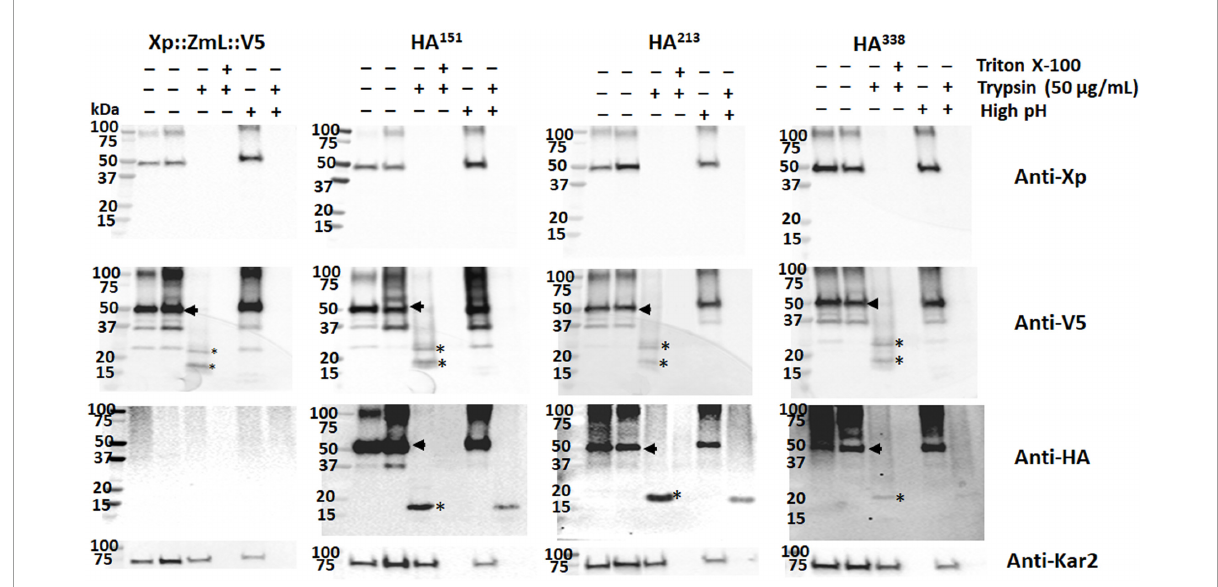
FIGURE5 Sequential high pH membrane reformation/protease protection assay of microsomes containing DGAT1. High pH conditions reformed the sealed microsomal compartment, allowing protease cleavage of luminal domains from integral domains embedded in the membrane bilayers (Wu et al., 2003). The addition of trypsin alone resulted in the total disappearance of the Xpress (Xp) tag and the appearance of conserved fragments containing the V5 tag; when both trypsin and triton X-100 were added the V5 signal was also lost. Combining high pH treatment with trypsin digestion resulted in the disappearance of the V5 tag of all Xp::ZmL::V5, Xp::ZmL-HA 151 ::V5 (HA 151 ), HA 213 , and HA 338 . The data indicates the C-terminus is located in the lumen. In contrast to the C-terminal tags, although the addition of trypsin after high-pH conditions resulted in the reduction of the HA signal in all HA 151 , HA 213 , and HA 338 , these conserved fragments were visible. Thus residues around 151, 213, and 338 appear to belong to the integral membrane. Arrows indicate full-length DGAT1s, * indicated fragmentation of DGAT1s after protease digestion.